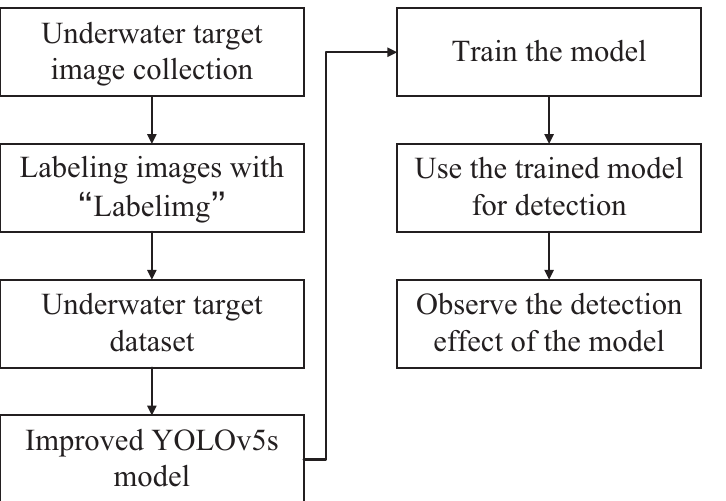
Figure 1. Diagram of process for applying the modified YOLOv5s model to underwater target